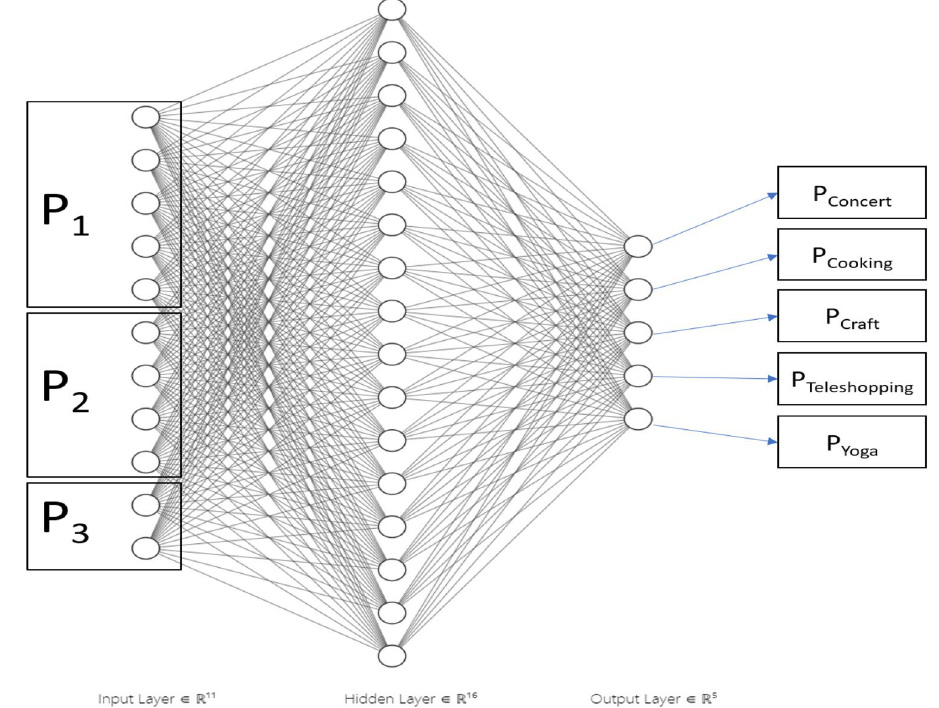
Fig. 5 The final combination phase of the proposed Hybrid Deep Net for action image classification. (P1, P2 and P3 are discussed in Fig.